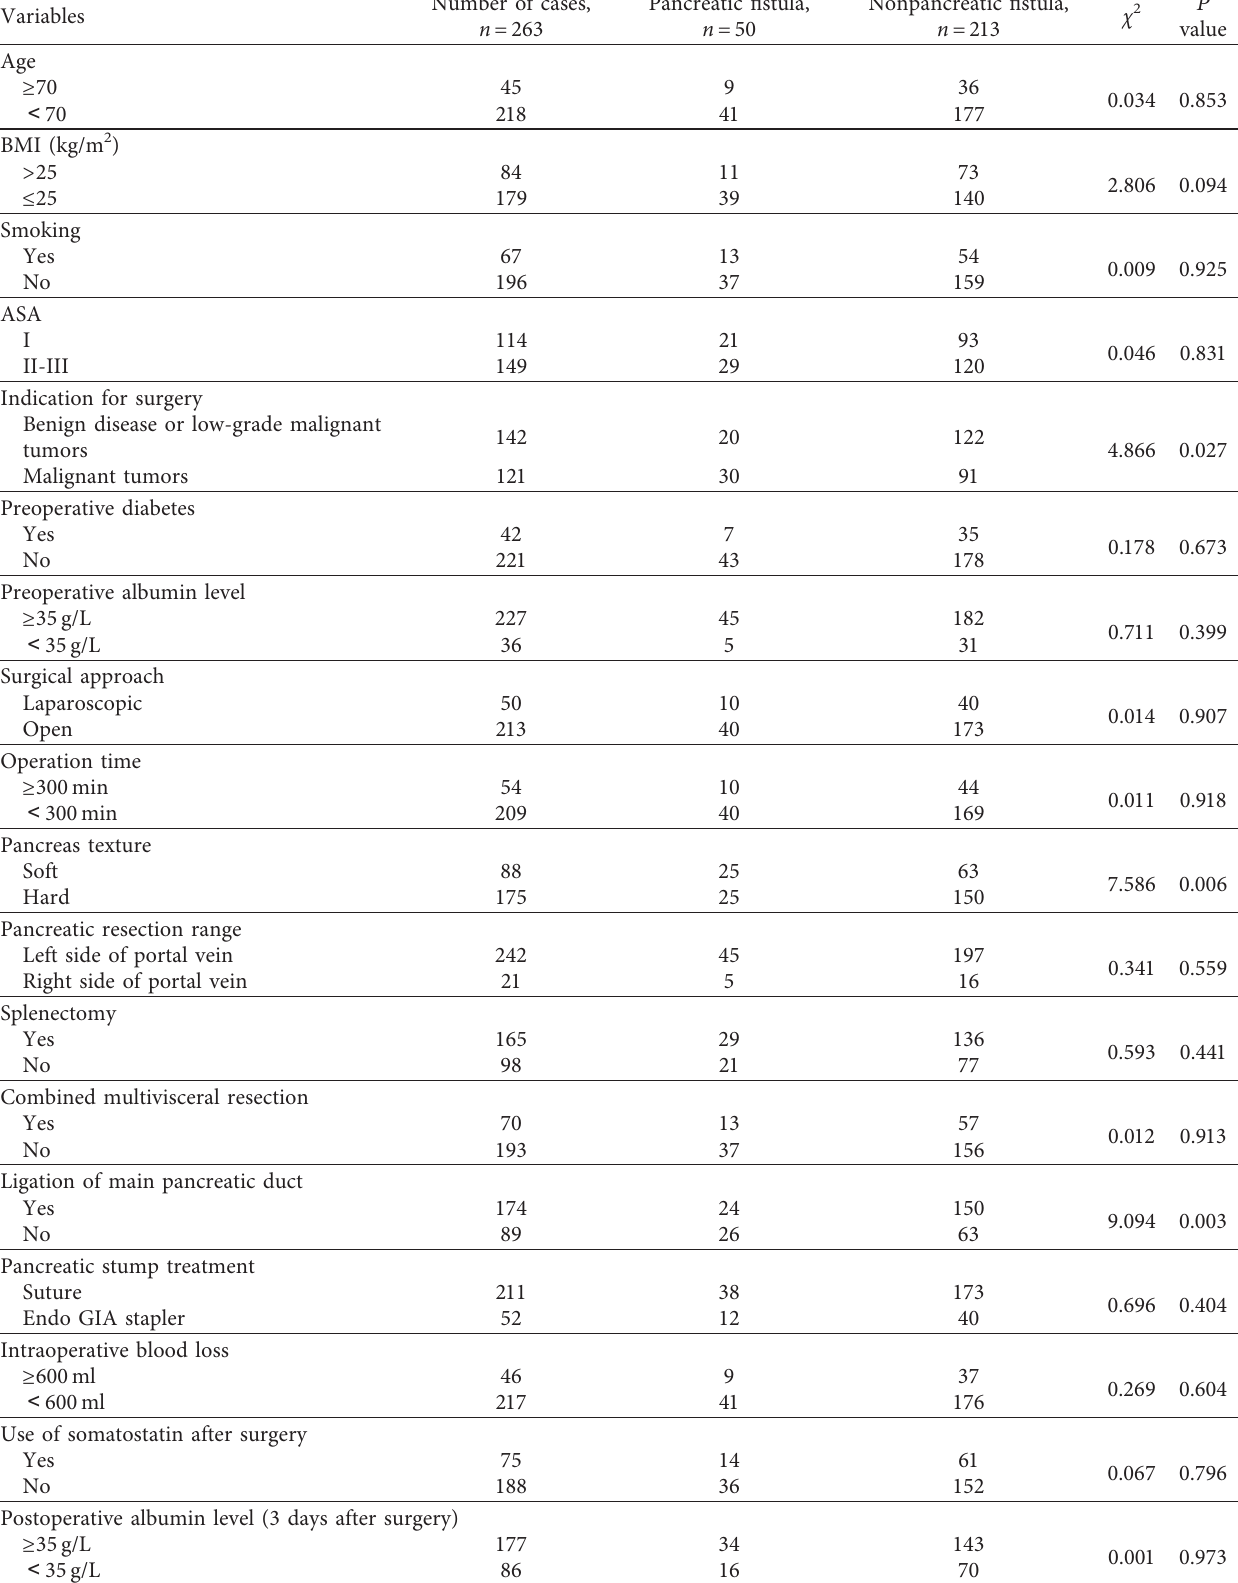
Table 4: Univariate analysis of risk factors for postoperative pancreatic fistula after distal pancreatectomy (DP).